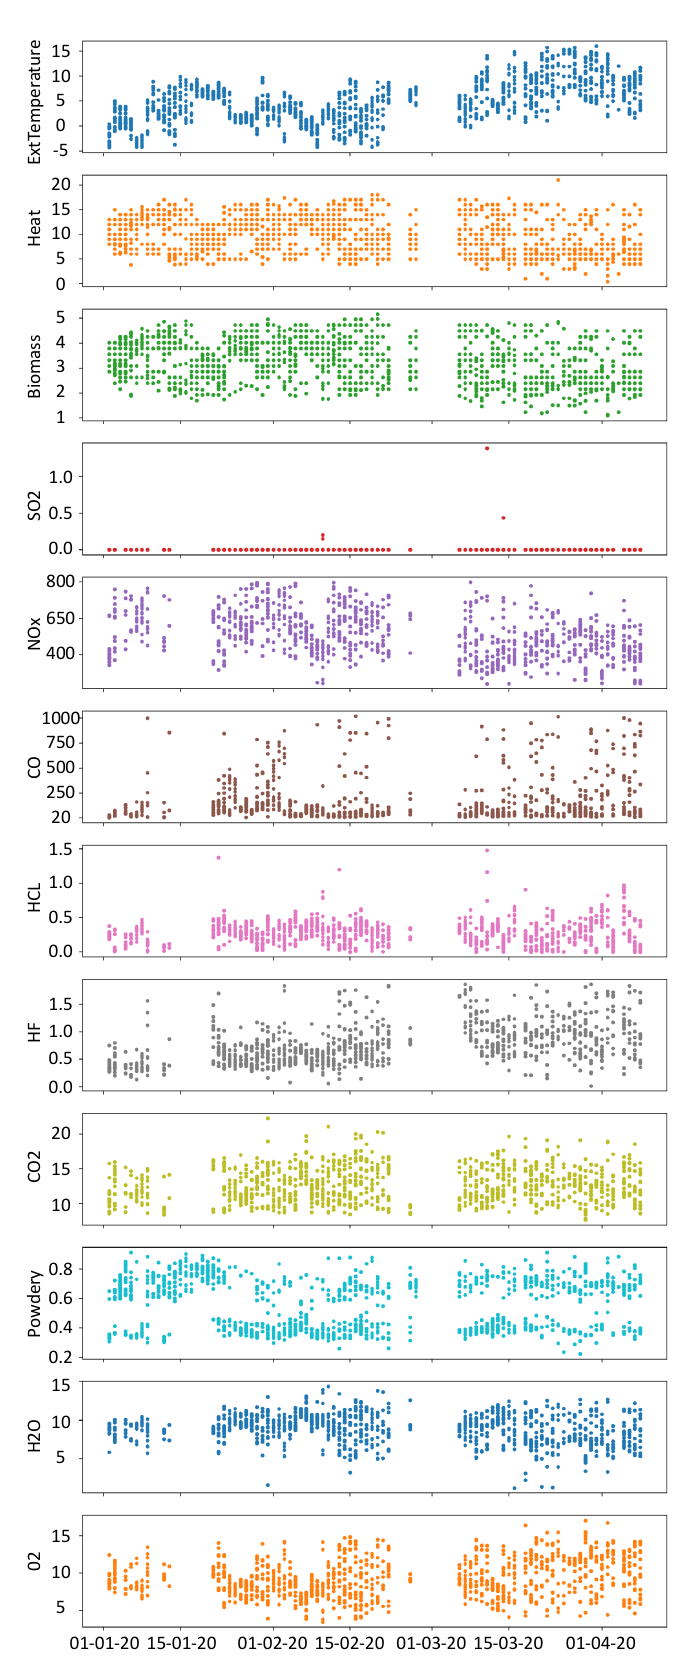
Figure 3. Hourly diagrams of measured variables during the period of four months.